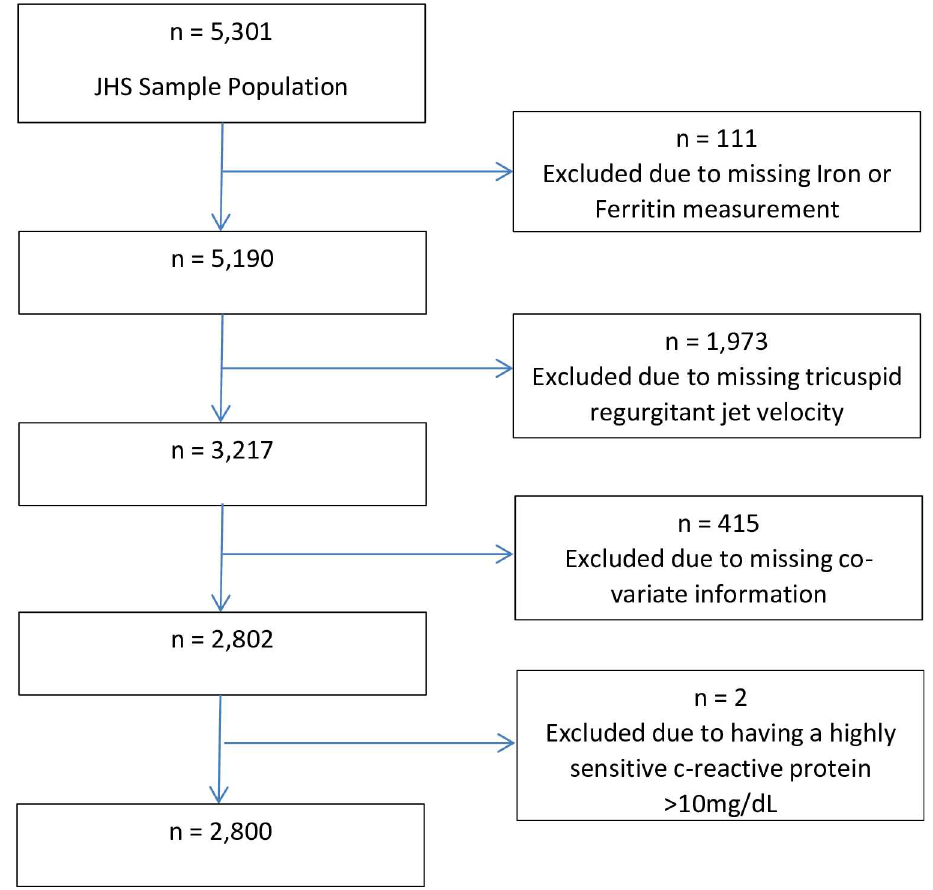
Fig 1. Details of analysis sample